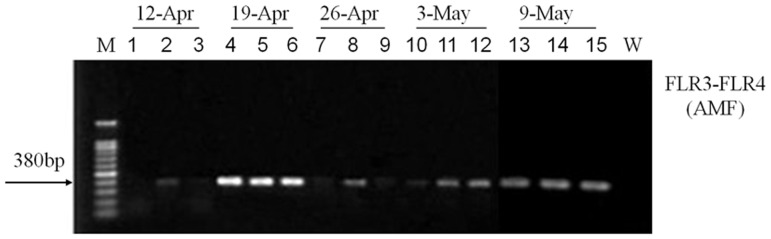
PCR detection of Glomeromycota (FLR3-FLR4) in colonized roots from experiment 1 (three replicates per sampling date).(W) indicates water control, (M) indicates molecular weight marker 100 bp ladder (Tiangen Biotech).